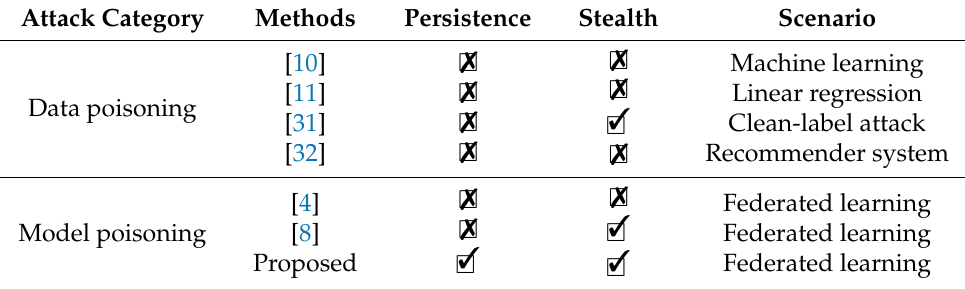
Table 1. A summary of recent poisoning attacks against machine